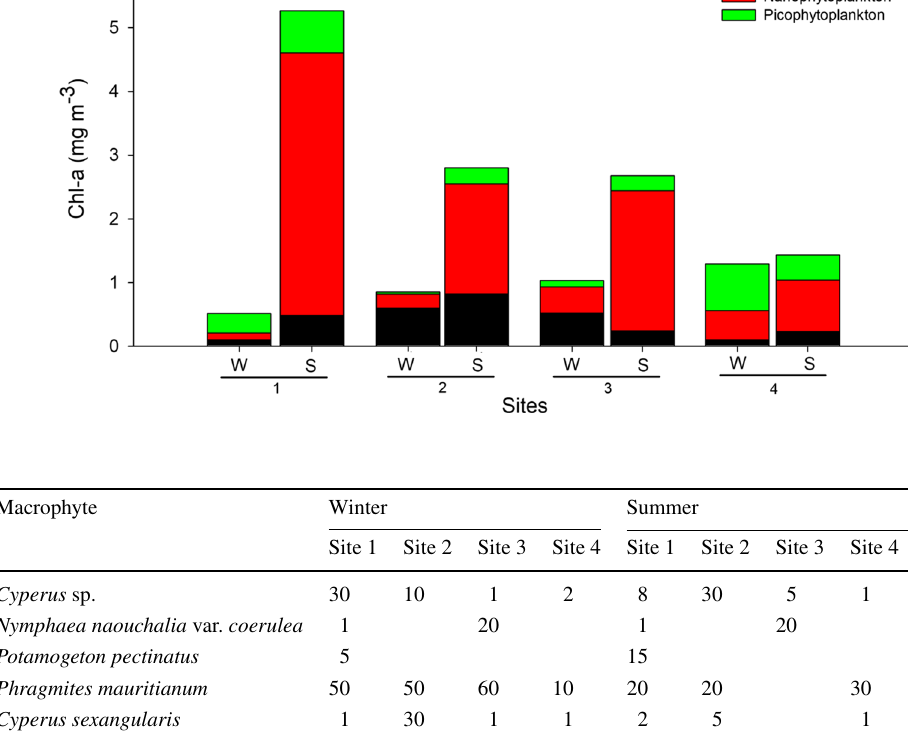
Fig. 2 Size-fractionated chloro- phyll- a concentration (mg L −1 ) measured from Sambandou wetland